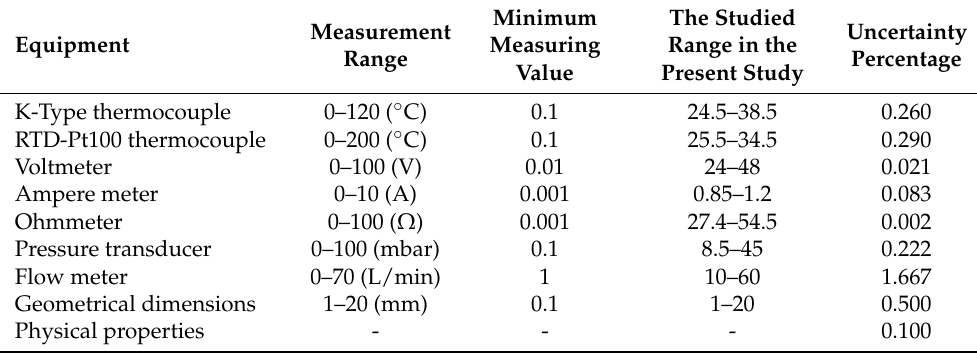
Table 3. The equipment’s information and